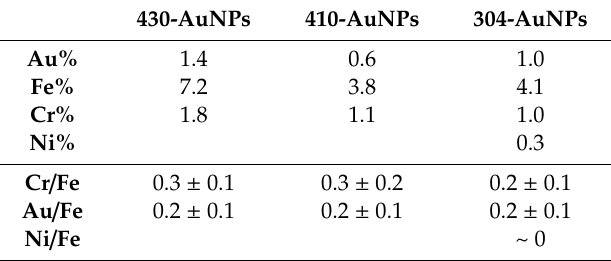
Figure 2. Au4f high resolution regions relevant to used ( a ) AISI 430, ( b ) AISI 410, ( c ) AISI 304. Table 2. Surface chemical composition of colloids synthesized with AISI 430, 410 and 304, obtained by XPS. The main elements are reported; the complete dataset is shown in Table S2. Error is expressed as the larger value between the error associated to a single quantification and one standard deviation; error on Fe, Si, Cr, Ni and Au percentages is ± 0.2%; error on the abundance of other elements is ± 0.5%. Cr / Fe, Au / Fe and Ni / Fe ratios of the same samples are showed, as well.